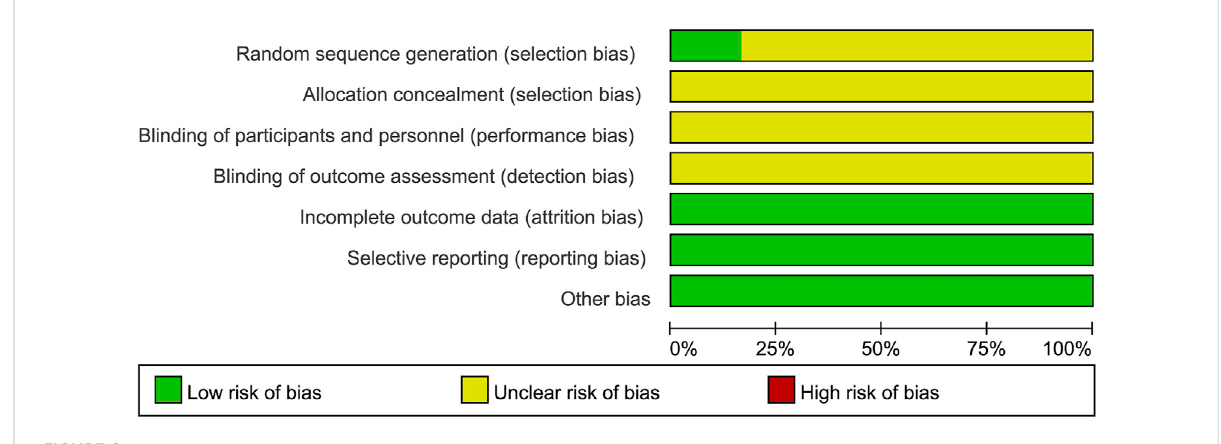
FIGURE 2 Risk bias evaluation diagram of the included